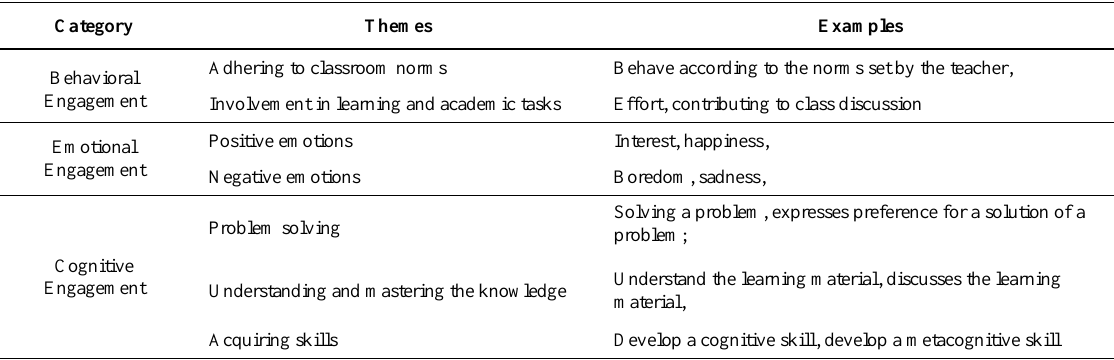
Table 2. Categories, themes and indicators for each theme according to Fredricks et al.